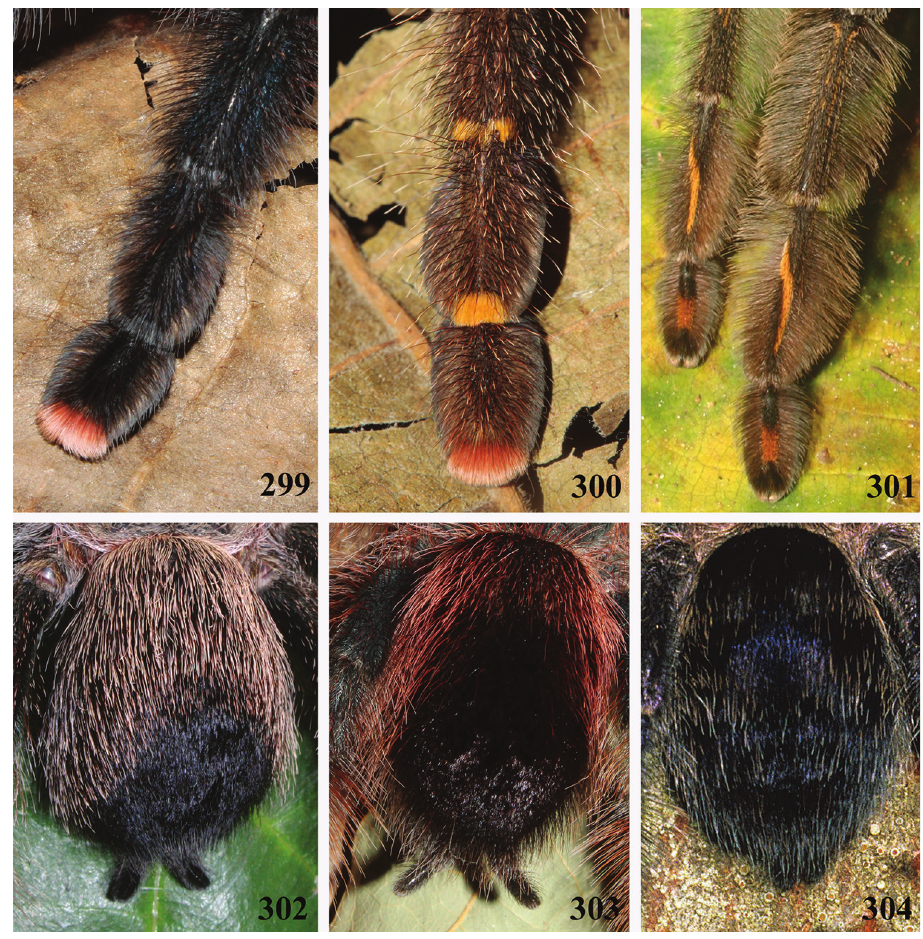
Figures 299–304. Legs and abdominal characters. 299–300 leg rings coloration on metatarsi and tibiae, and guard-setae coloration on legs 299 Avicularia avicularia , female, whitish leg rings and homogeneous coloration along guard-setae on legs 300 Avicularia rufa , female, yellow leg rings and guard-setae with darker base and contrasting whitish apex on legs 301 Psalmopoeus irminia , male, longer setae laterally pro- jected on legs 302 Avicularia rufa , female, abdominal setae covering heterogeneously 303 Avicularia avicu- laria , female, abdominal setae covering heterogeneously 304 Avicularia purpurea , female, abdominal setae covering homogeneously. Photos: 299–301 R. Bertani; 302–303 C. S. Fukushima, 304 R. C.